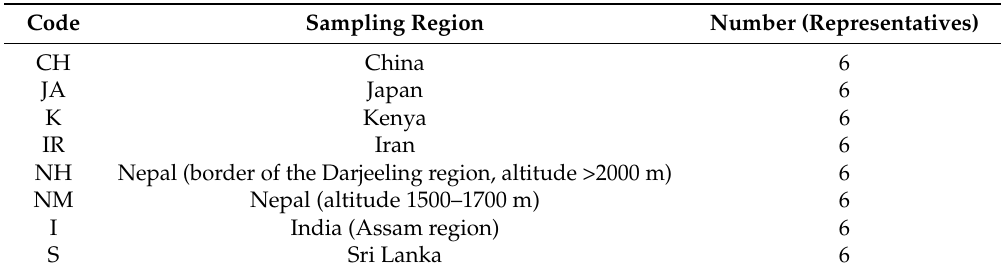
Table 3. The geographical origin and number of samples for the investigated black teas.